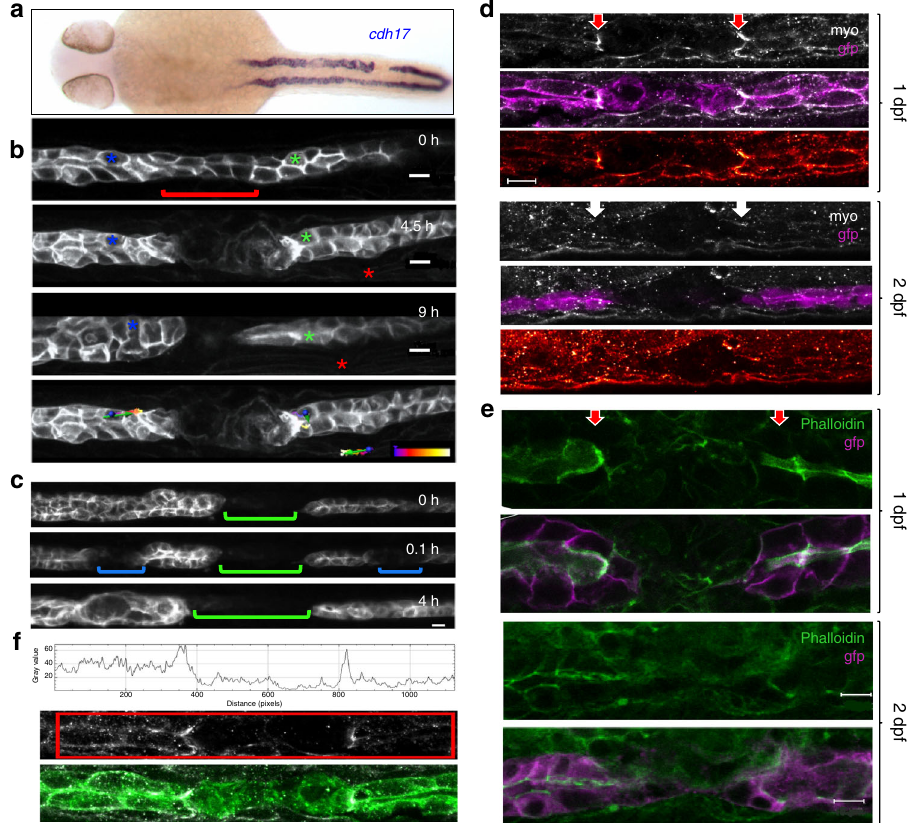
Fig. 1 Pronephric ducts injured 1 day after fertilization fail to repair. a In situ hybridization for the pronephros-speci fi c probe cadherin17 ( cadh17 ) reveals that an injury applied 24 h after fertilization (24 hpf) is not repaired. The in situ hybridization was performed 24 h after injury. b Frames taken from a time-lapse movie of cldn2b:lyn-GFP transgenic embryo injured 30 hpf. Cells (blue and green asterisks) next to the gap exhibit little net movement. The gap persisted for 9 h after the injury. The red asterisk marks a somite border serving as a landmark. Tracking lines are color coded, ranging from blue to white (0 – 9 h) (scale bars, 10 µ m). c Repair occurs in the absence of fl uid fl ow. Frames were taken from a time-lapse movie injured fi rst 1 day post fertilization (dpf) (green bracket), with two subsequent injuries (blue brackets) applied 2 dpf. Despite the lack of fl uid fl ow both secondary injuries (blue brackets) recovered after 4 h. d Staining of cldn2b:lyn-GFP transgenic zebra fi sh embryos wounded at 1 or 2 dpf, fi xed 30 min post wounding, and stained for phospho-myosin light chain-2 (MyoP). Activated myosin was detected at the edges of the pronephros injury in 1-day old embryos (red arrows), but not in 2-day-old embryos (white arrows). The bottom panel of each image shows the phospho-myosin levels using a color-coded range indicator (scale bars, 100 µ m). e Staining of cldn2b:lyn-GFP transgenic zebra fi sh embryos wounded 1 or 2 dpf, fi xed 4 h after wounding, and stained with phalloidin for actin. Actin staining was detected on the apical surface of cells close to the injury in both 1-day and 2-day old embryos. Actin staining was more prominent in 1-day embryos, and appeared perpendicular to the duct lumen (red arrows) (scale bars, 100 µ m). f Quanti fi cation of the pixel intensity within the marked region of a single representative confocal plane from the MyoP staining (middle panel) of an embryo injured 1 dpf. The histogram depicts two peaks with increased levels of phosphorylated myosin adjacent to the injury. The bottom panel represents the merged image of GFP/MyoP